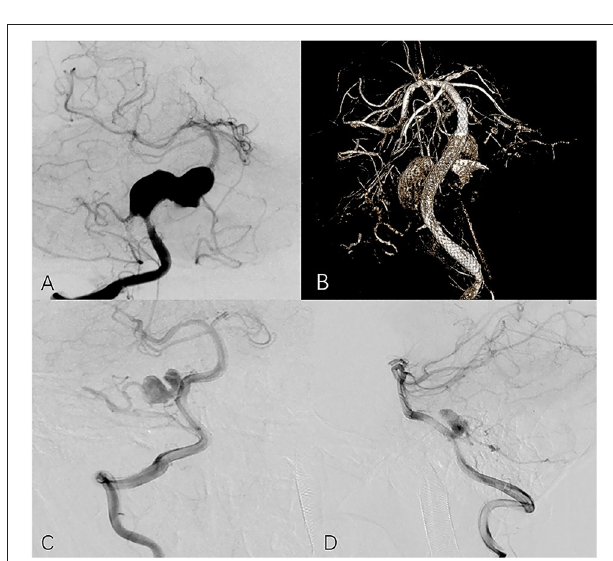
TABLE 3 | Procedural details and follow-up